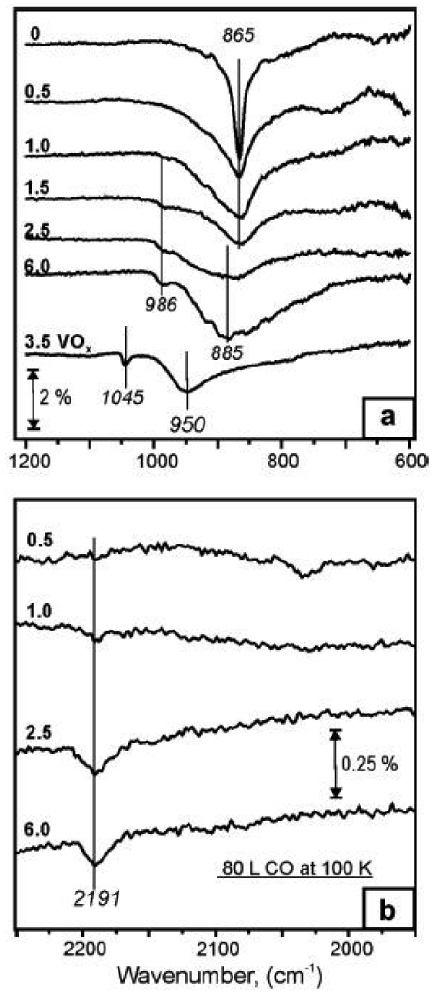
Fig. 12 – (a) The phonon region of IRA-spectra of the niobia/alumina samplesasafunctionofniobiacoverageasindicated(inÅ).Aspectrum for similarly prepared vanadia/alumina is also shown, for comparison. (b) IRA-spectra of 80 L CO adsorbed at 100 K as a function of niobia coverage. All spectra are offset for clarity (Uhl et al.